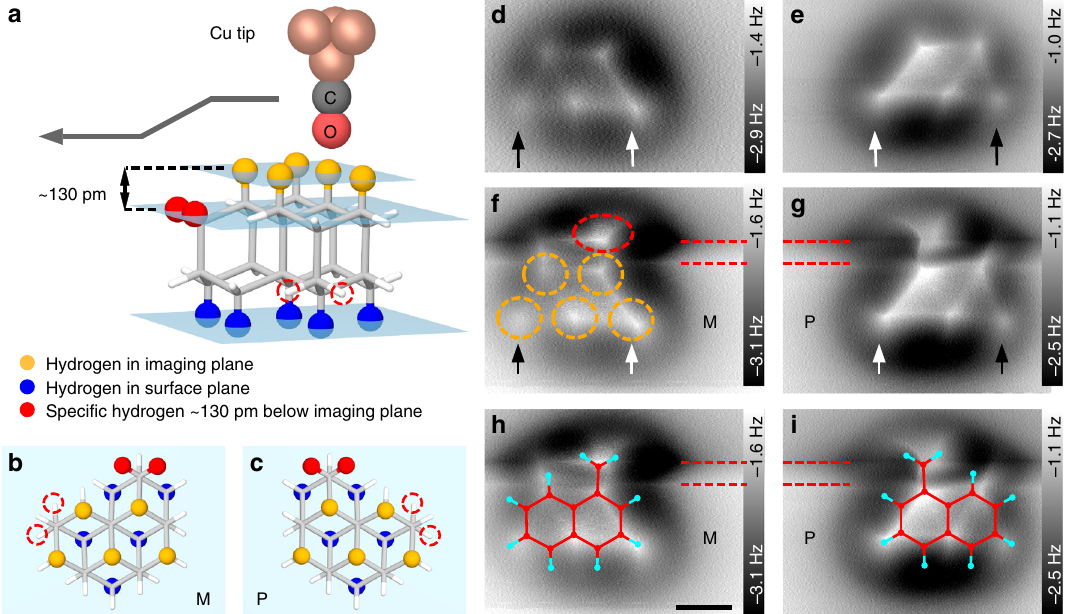
Fig. 4 Adsorption structure of [123]tetramantanes. a Side view sketch of ( M )-[123]tetramantane with the Olympic ring pattern of hydrogen atoms facing upwards (see fi ve orange hydrogens). The absolute con fi guration can be determined by locating two speci fi c hydrogen atoms (red atoms) ≈ 130 pm below the imaging plane. b , c Top view sketches of ( M )-[123]tetramantane and ( P )-[123]tetramantane showing the arrangement of Olympic ring patterns in the imaging and surface planes (orange and blue atoms) and the speci fi c hydrogen atoms (red atoms and red dashed circles). d , e Constant height AFM scans of two different [123]tetramantanes. White and black arrows indicate the brighter (higher) and darker (lower) sides of the molecules, respectively. f , g Same molecules imaged with custom height pro fi le, i.e., in the region between the two dashed red lines the imaging height was linearly decreased by ≈ 130 pm. Both scans were started in the bottom of the images. Both images reveal a bright halo (red dashed oval in f ), which is either located on the right or the left side of the Olympic ring pattern (dashed orange circles). h , i Corresponding AFM scans with overlaid molecular structures of ( M )-[123]tetramantane and ( P )-[123]tetramantane. For clarity, only the plane containing the two speci fi c hydrogens is plotted. Please note that the speci fi c hydrogens are either connected to the C – 12 or C – 22 sites (according to IUPAC designated carbon numbers for [123]tetramantane). Scale bar: 0.3